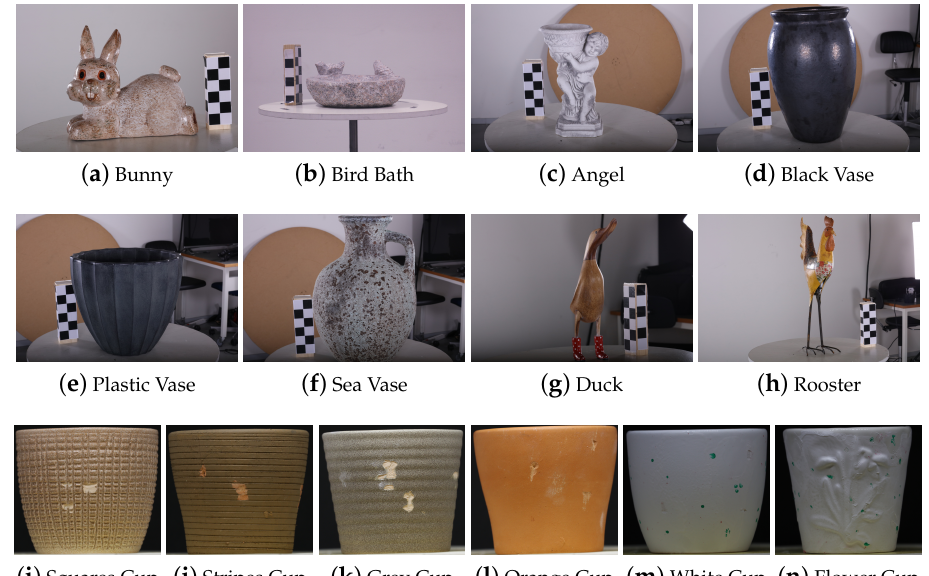
Figure 9. Objects selected for the robustness test. These objects have widely varying shape, size, roughness profiles and